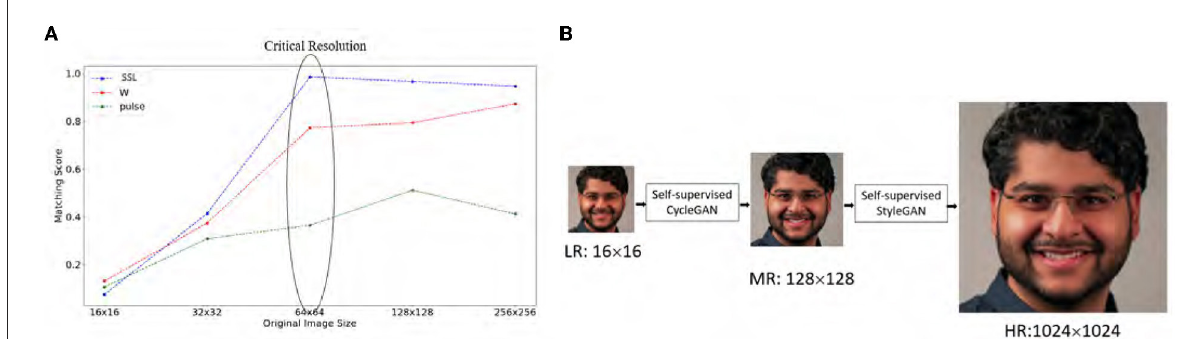
FIGURE1 Motivation to study extreme FSR. (A) Preserving identity information using the Openface face matching tool (Amos et al., 2016) and StyleGAN FSR is infeasible below the critical resolution of 64 × 64. Note that our two-step SSL-based approach (marked blue) significantly outperforms PULSE (Menon et al., 2020) (marked green). (B) This work presents a two-step SSL-based approach to extreme FSR–MR serves as the stepping stone to facilitate both degradation learning and image